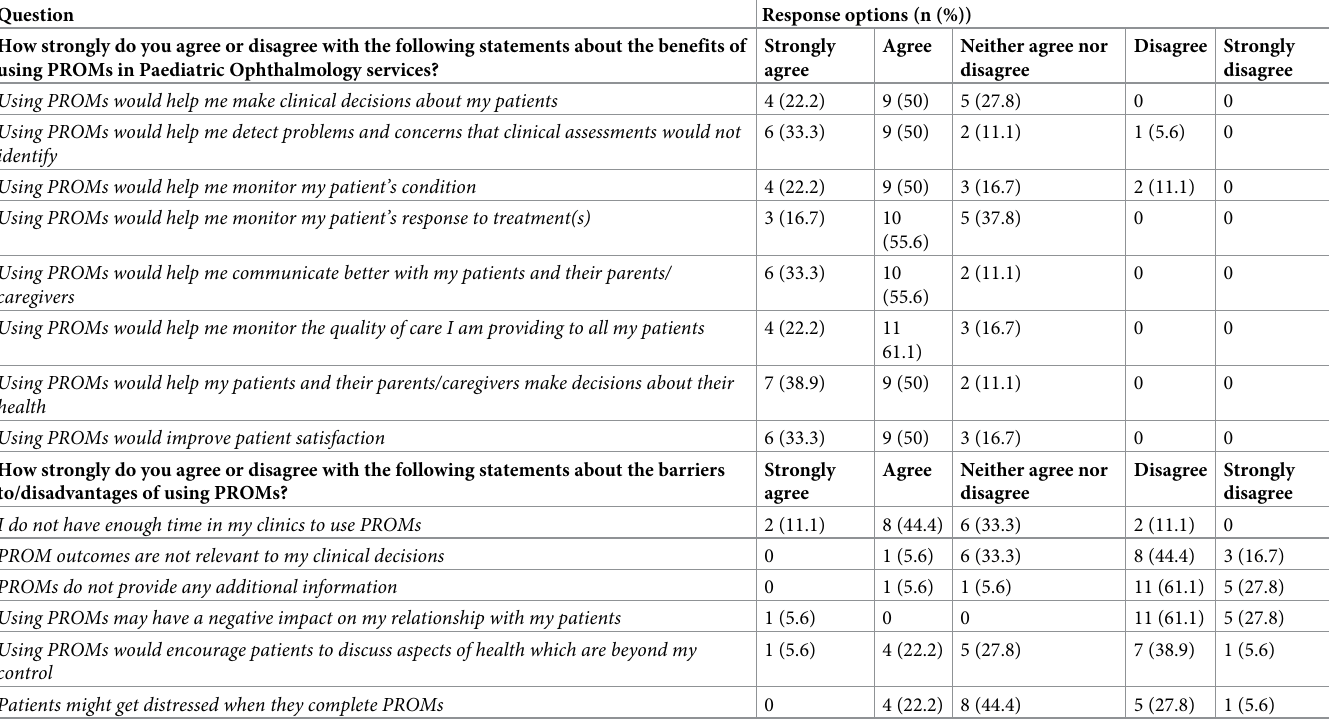
Table 2. Agreement and disagreement with benefits and barriers to using PROMs in routine clinical